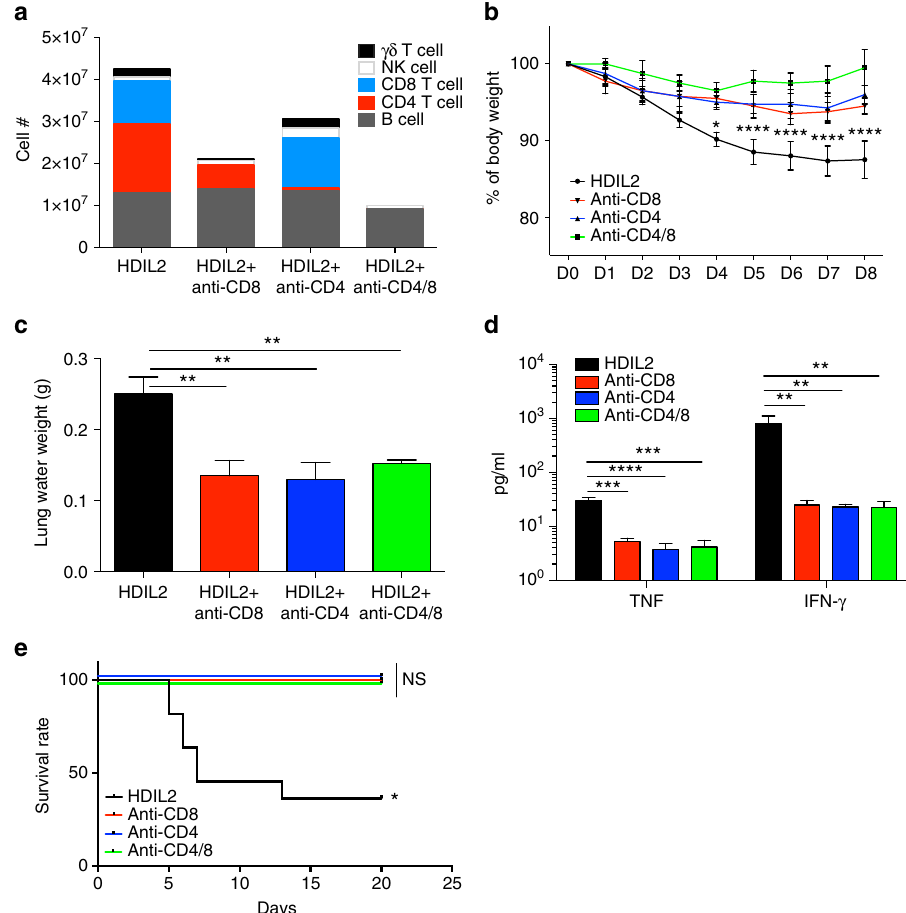
Fig. 3 Both human CD4 + and CD8 + T cells contribute to high-dose IL-2 induced toxicity. 10 − 14-week-old human immune system (HIS) mice treated with PBS or high-dose IL-2 (HDIL2) ( n = 5 per group) were killed at D8 post injection. HDIL2 HIS mice received mAbs against CD4, CD8, or CD4 and CD8 at D- 1 and D3 post IL-2 treatment. The data are pooled from two independent experiments. a Absolute cell counts of human immune cell subsets in spleen at D8 post IL-2 treatment. b Body weight change after HDIL2 and mAb depletion. The data are representative of two independent experiments. Comparisons are between HDIL2 HIS mice and the other groups by repeated-measures two-way ANOVA with a Sidak test. c Pulmonary edema was measured by lung water weight at D8 post IL-2 treatment. The data are analyzed by 1-way ANOVA test with a Tukey test. d Levels of cytokine TNF and IFN- γ were analyzed from sera of indicated groups by 1-way ANOVA test with a Tukey test. e Kaplan − Meier survival curves of indicated group ( n = 10 per group were analyzed by Log-rank test. * P < 0.05, ** P < 0.01, *** P < 0.001, **** P < 0.0001; NS, not signi fi